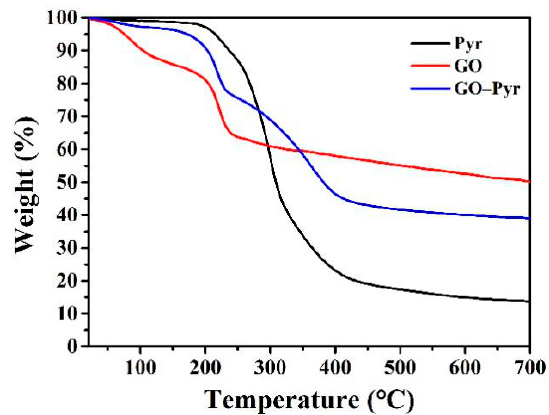
Figure 3. TGA curves of GO and GO–Pyr